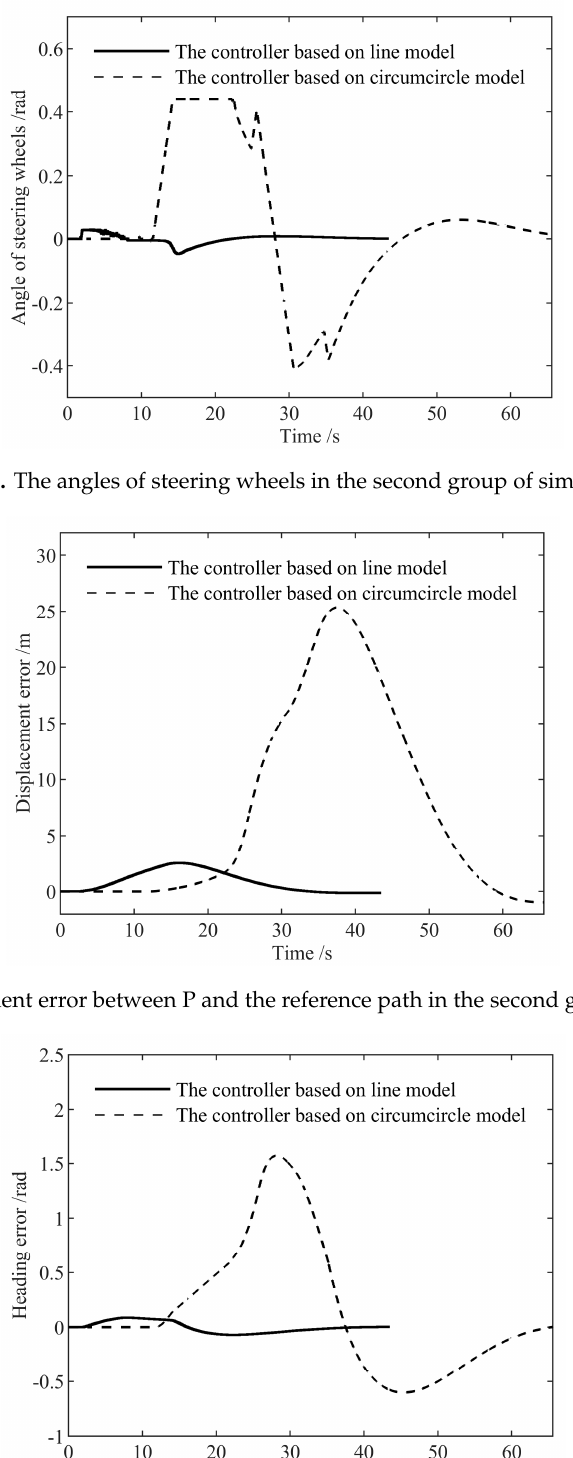
Figure 19. Longitudinal velocity in the second group of simulations.